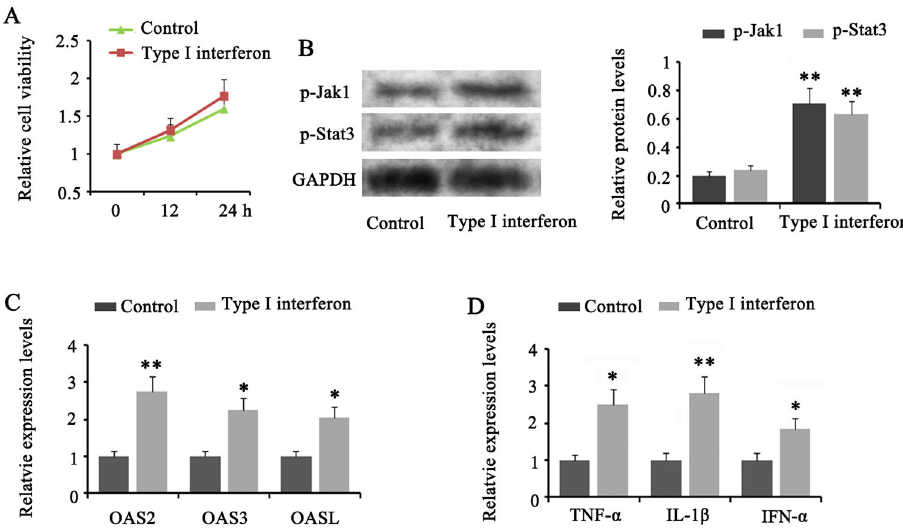
Figure 5. Type I interferon (IFN) increased expression of OAS2, OAS3, OASL, and in fl ammatory factors in Tcells. CD4 + Tcells were treated with IFN- a -2a. A , IFN- a -2a had no signi fi cant effect on the cell viability within 24 h. B , Western blot was performed to evaluate phosphorylation levels of Jak1 and Stat3. C , PCR was performed to evaluate OAS2, OAS3, and OASL expression in T cells. D , PCR was performed to evaluate expression of in fl ammatory factors in T cells. Data are reported as means ± SD. *P o 0.05, **P o 0.01 vs control (Student ’ s t -test).